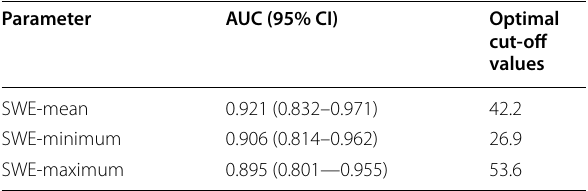
*Independent samples t-test was used Table 5 Optimal cut-off values of SWE parameters